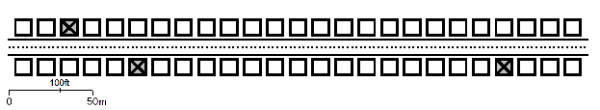
Street Diagram. The three Crohn's disease cases lived in the three houses marked with an X. The woman who had Crohn's disease before her move to the street lived in one of the unmarked houses. A six (6) inch tap water pipe in the middle of the street supplies houses on both sides. Water in this pipe travels in a continuous loop in both directions, with no dead ends in the system.